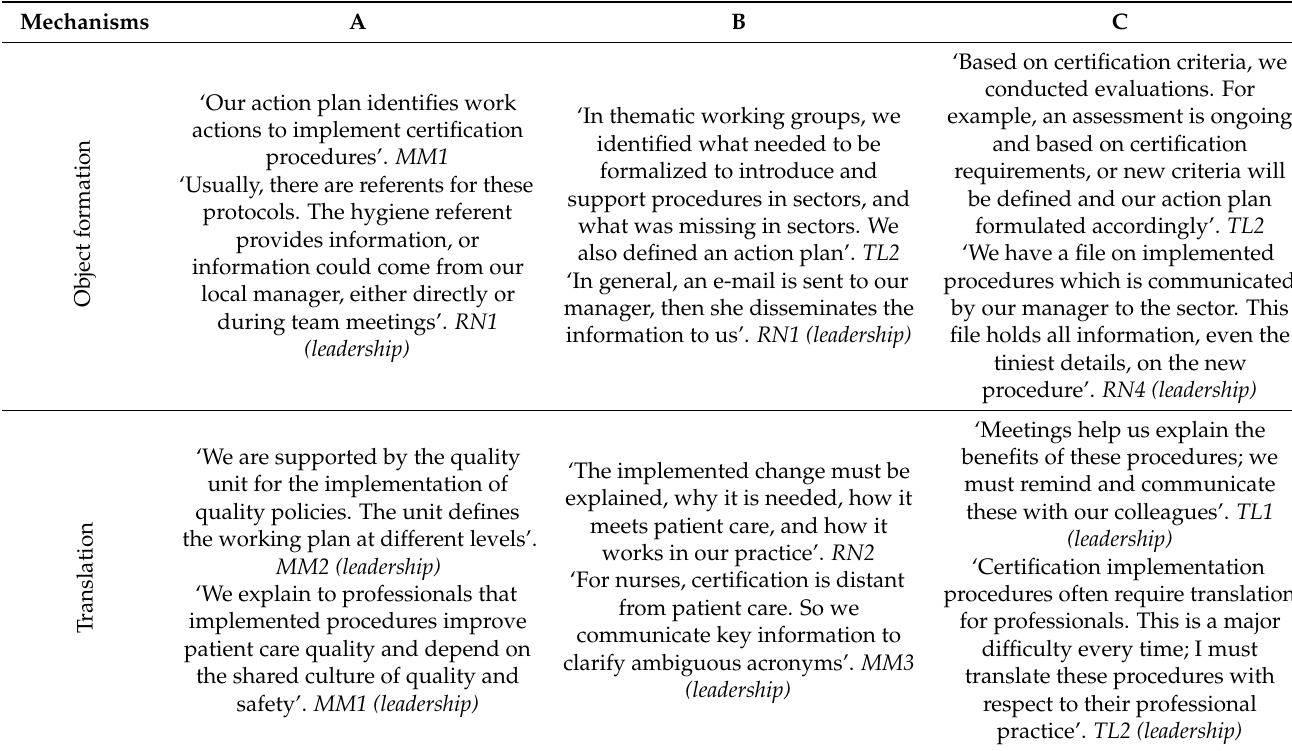
Table A3. Site (A, B, and C) comparisons of object formation and translation mechanisms and interference with the leadership.